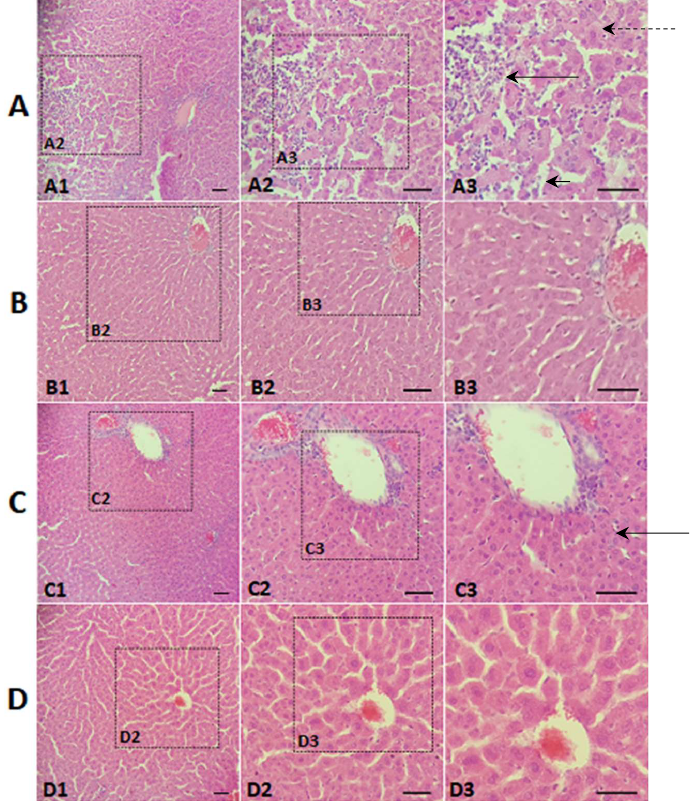
Figure 2. Photomicrographs of histological sections of hepatic tissue, stained with haematoxylin and eosin. Zoom: 10 × , 20 × , 40 × : 200 µ m, 100 µ m, 50 µ m. ( A ) Positive control group (PCG); ( B ) Negative control group (NCG); ( C ) Mung bean flour group (WMBG); ( D ) Germinated mung bean flour group (GMBG). Long black arrow: Inflammatory infiltrate, Short black arrow: Necrotic cell, Long black dotted arrow: Steatosis (microvesicular). Results of the semi-quantitative analysis of the histopathological findings: NCG: 1+, PCG: 4+, WMBG: 2.8+, GMBG: 2.2+. (Consider: 1+ = no change; 2+ = minor changes; 3+ = moderate changes; 4+ = severe